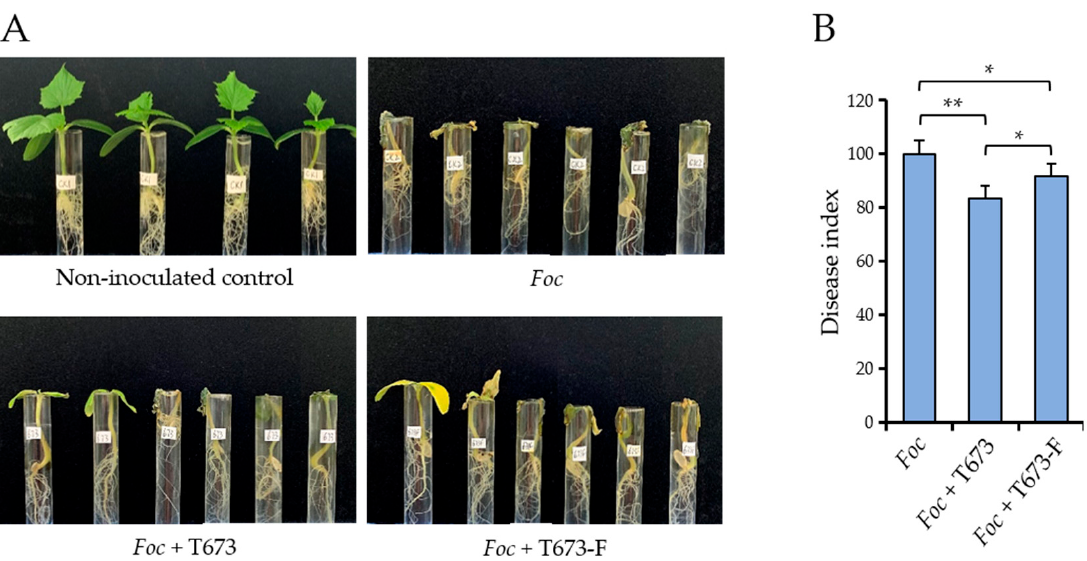
Figure 7. Biocontrol activity of T. harzianum strains T673 and T673-F against F. oxysporum f.sp. cucumerinum ( Foc ). ( A ): Phenotype of plants inoculated with Foc , or co-inoculated with Foc and T. harzianum strains T673 or T673-F. Non-inoculatd plants and plants inoculated with Foc alone served as controls. ( B ): Disease severity of plants inoculated with Foc alone or co-inoculated with T. harzianum strains T673 or T673-F, as indicated by the disease index (percentage of dead cucumber plants at 13 dpi). Every treatment ( n = 8 plants) was performed in three replicates. Data in ( A , B ) were from plants at 13 dpi, and t -test was used for statistical analysis. Single asterisks indicate significant differences ( p < 0.05); double asterisk indicates highly significant differences ( p < 0.01).